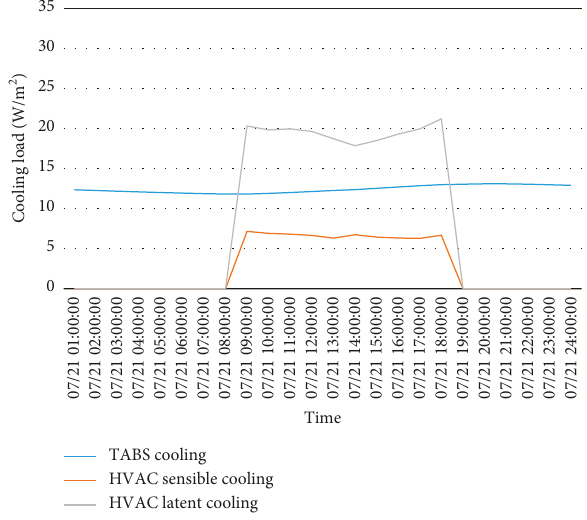
Figure 16: Amount of TABS and DOAS cooling in the office space.